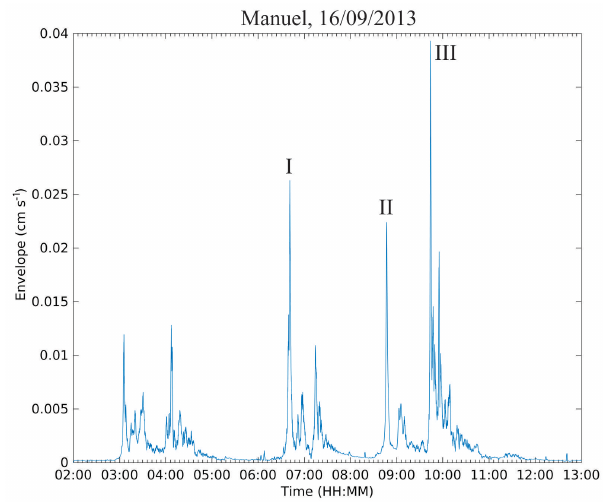
Figure 7. Seismic record of the lahar triggered during Hurricane Manuel, on 15 September 2013, recorded along the Montegrande ravine.